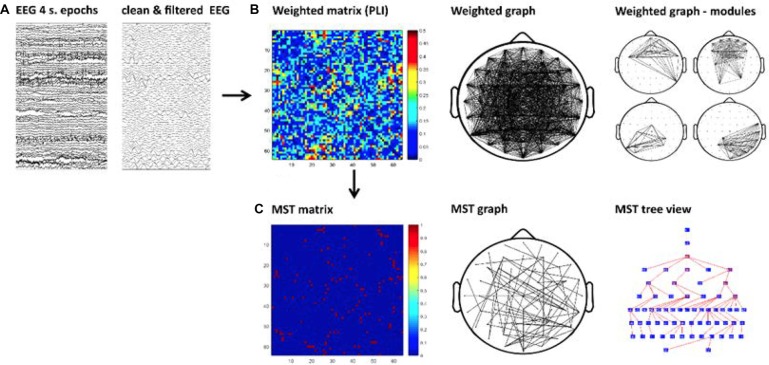
Schematic of the graph analysis. First, artifact-free epochs were Independent Component Analysis (ICA) cleaned and filtered for each frequency band (A). Second, the functional connectivity matrix based on phase lag index (PLI) is calculated for each frequency band and epoch (B-left). A weighted graph is derived from the matrix (B-middle) allowing the study of modularity, which is presented in Supplementary Material (B-right). Finally, the Kruskal’s algorithm is applied to obtain a minimum spanning tree (MST) matrix (C-left). The tree can be displayed on a scalp projection (C-middle). The tree view shows the hierarchical structure of the graph starting from an arbitrary root node, the color map of the nodes from blue to red represents lower to higher betweenness centrality (BC; C-right). For illustrative purpose this figure shows the MST obtained from a single epoch in one participant.